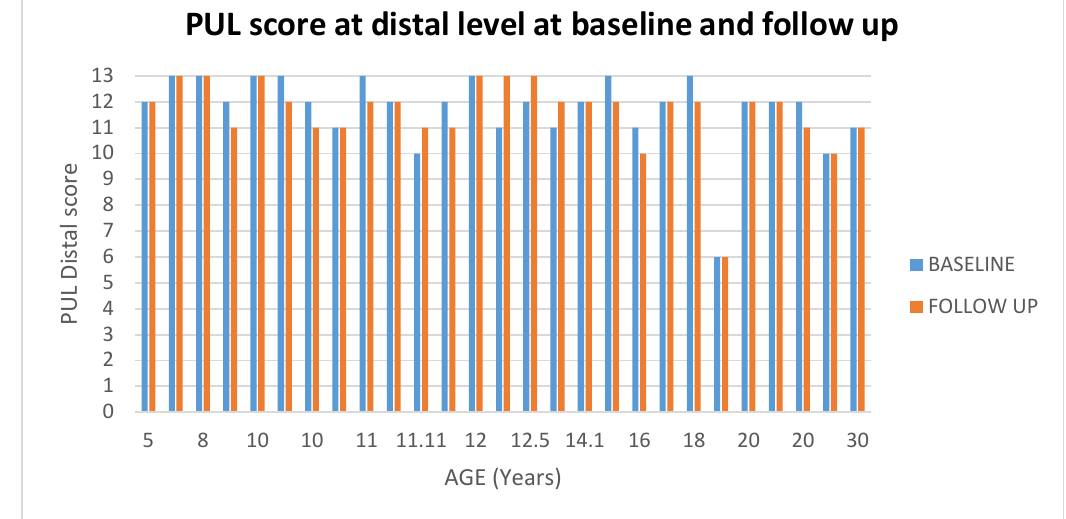
Figure 12. showed scores in PUL at distal level at baseline and at follow up according to age. Figure 12. Showed scores in PUL at distal level at baseline and at follow up according to